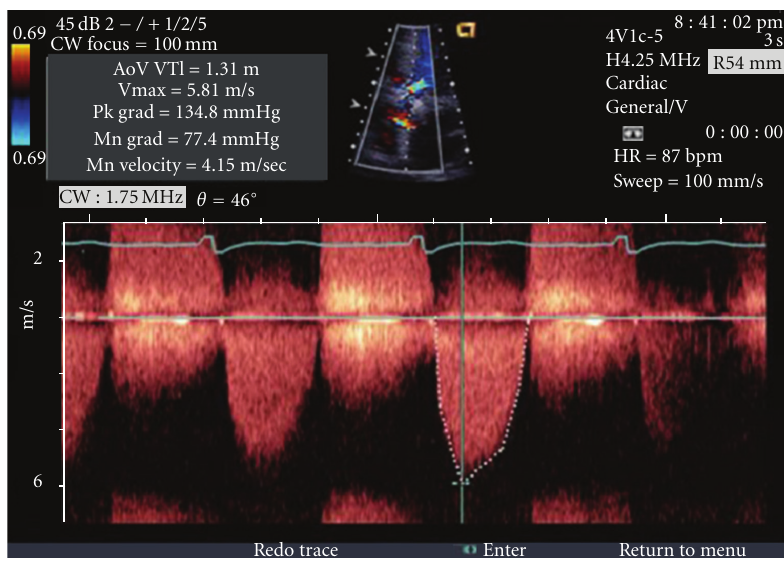
Figure 2: Echocardiogram showing criteria for critical aortic stenosis.